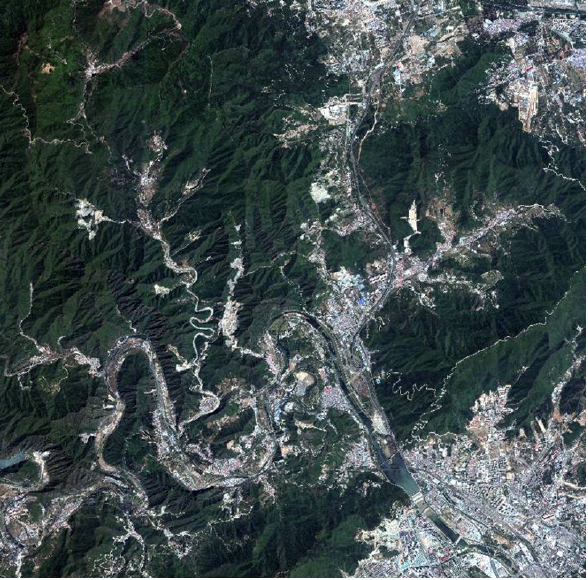
Figure 2. Initial image of the Mentougou city from the SuperView-1A satellite for May 5, 2017